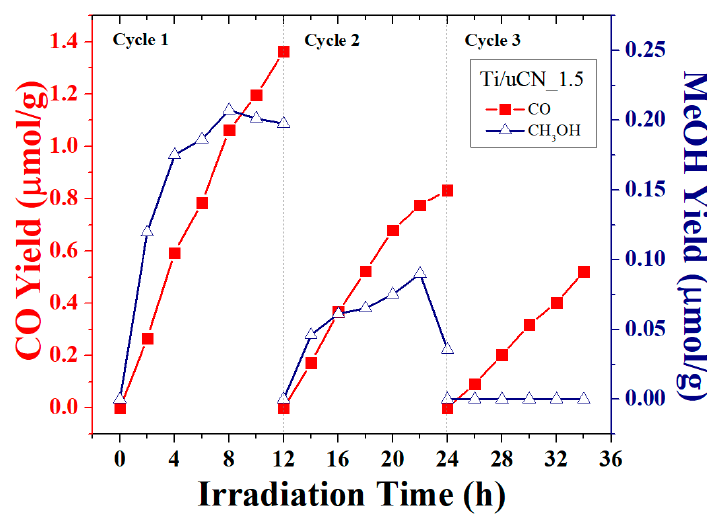
Figure 10. CO and MeOH yield from Ti / uCN_1.5 under three reaction cycles.